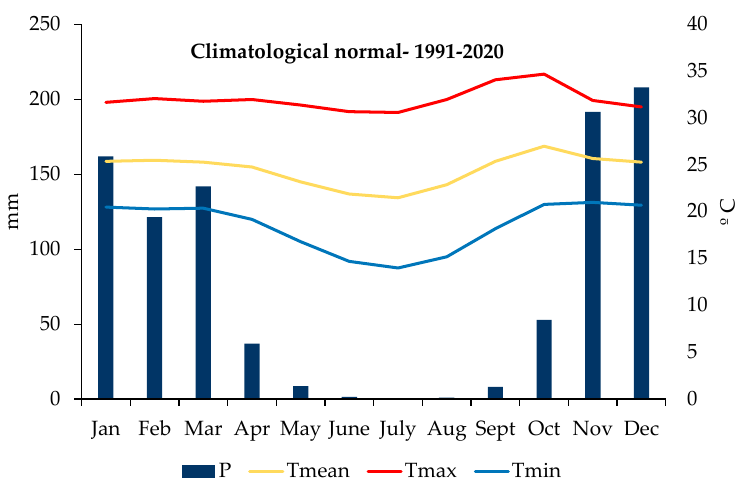
Figure 2. Climatological normal of the study region extracted from station 83,386 of INMET (Instituto Nacional de Meteorologia).